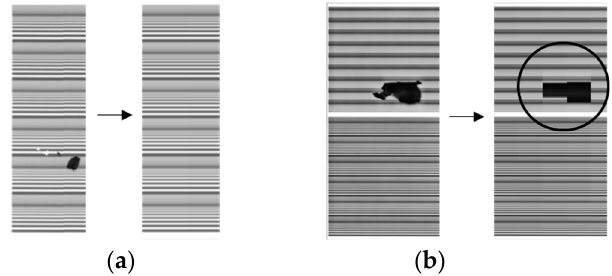
Figure 12. Applying the one-dimensional median filtering to the block image can remove small defects in ( a ) but cannot remove the large defects in ( b ).